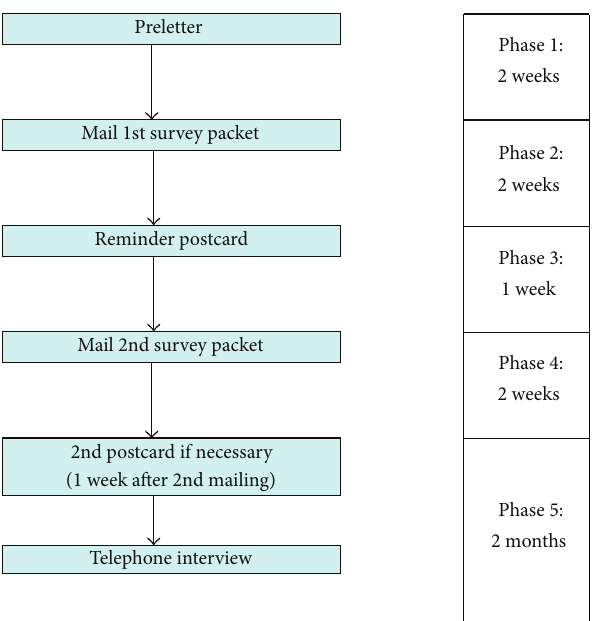
Figure 1: Diagram of 2007 LAMB survey